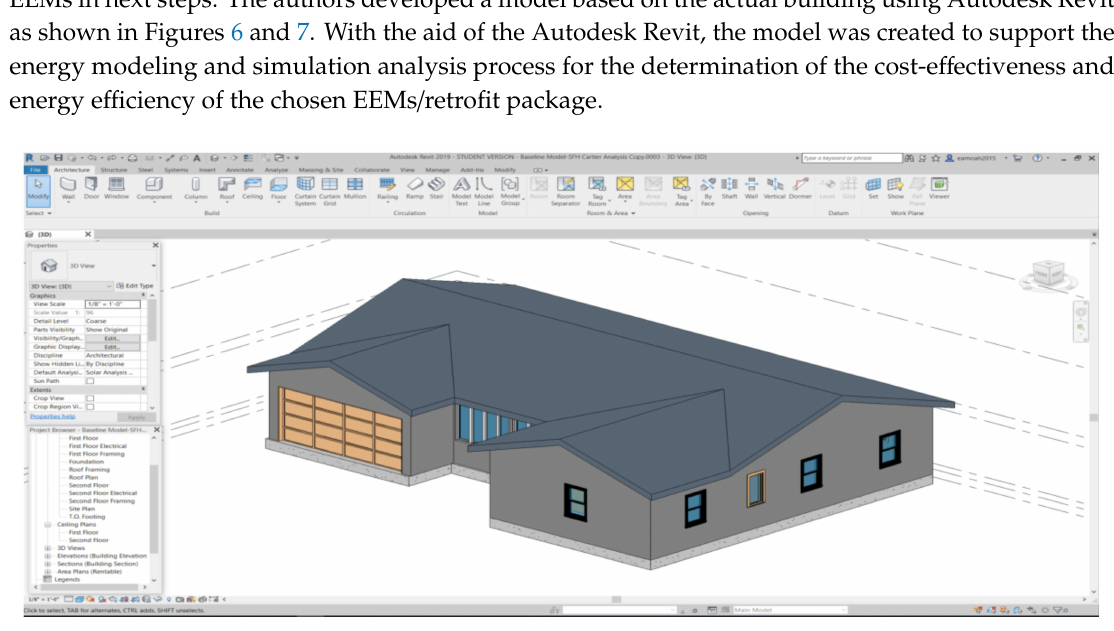
Figure 6. The baseline building model in